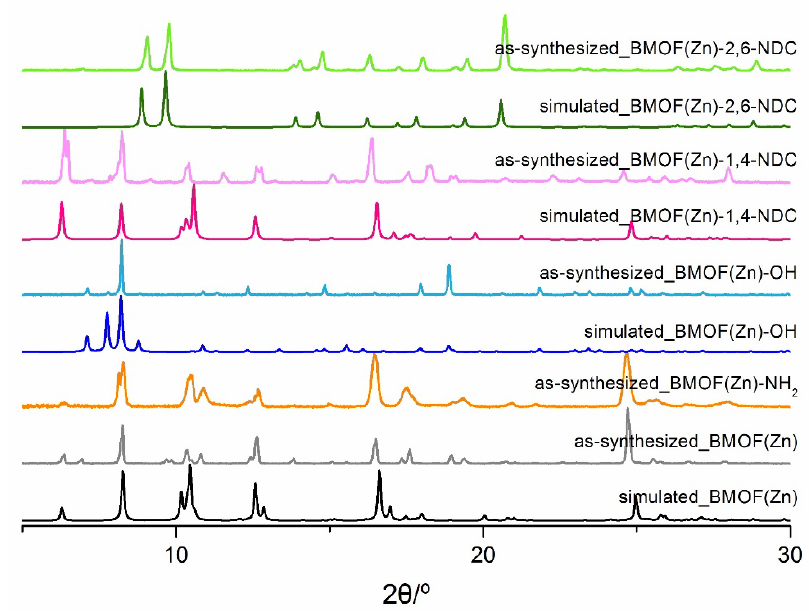
Figure 4. PXRD patterns of BMOFs (BPY MOFs) with different functionalities on the BDC ligand.